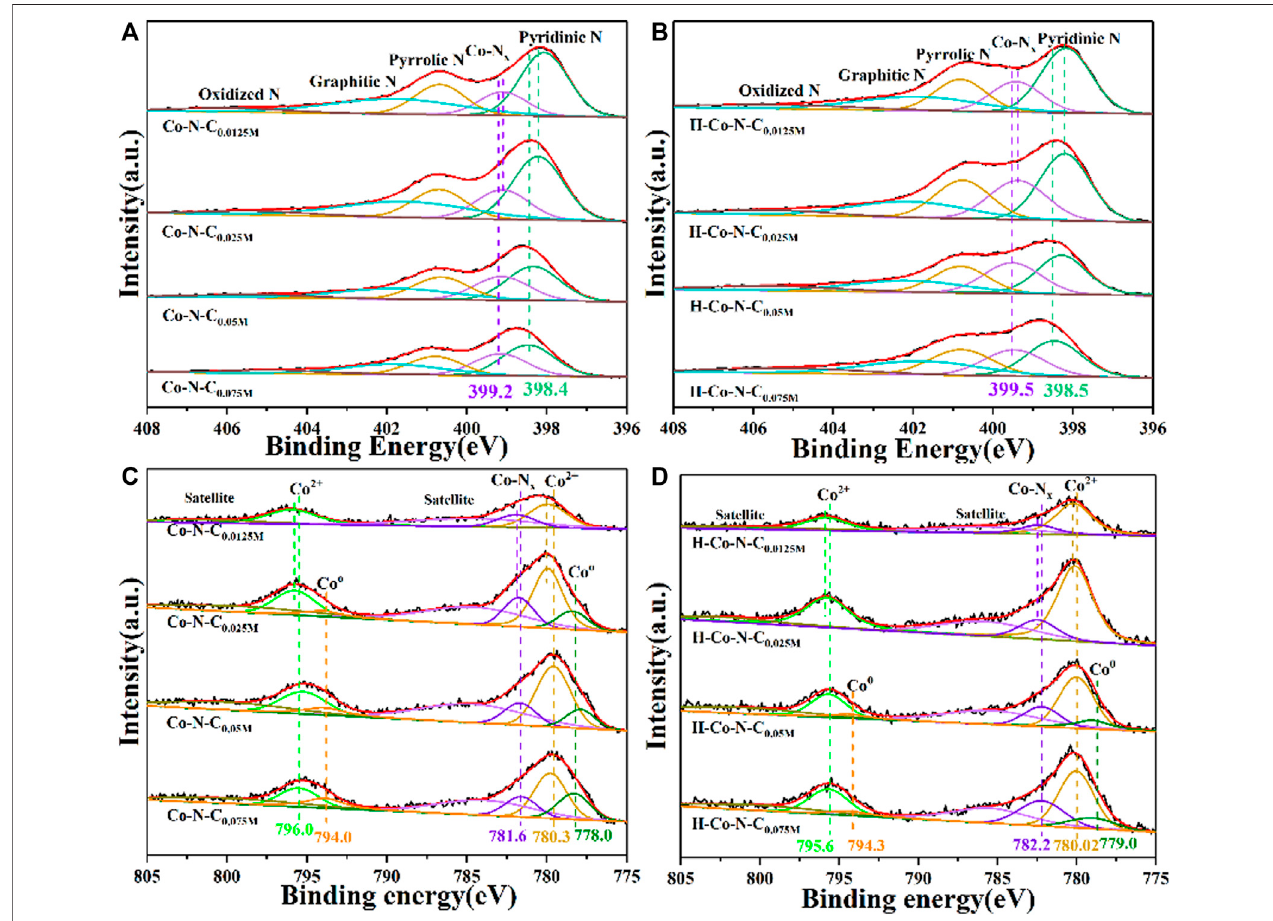
FIGURE 3 | High-resolution N 1s spectra of (A) Co-N-C X and (B) H-Co-N-C X , and high-resolution Co 2 p spectra of (C) Co-N-C X and (D) H-Co-N-C X .